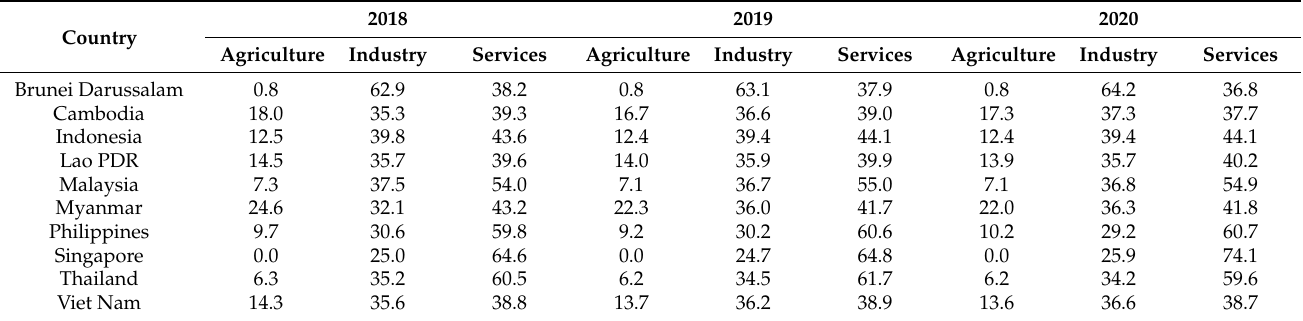
Table 1. ASEAN GDP Share of Major Group of Economic Sectors (1) , 2018–2020 (in per cent).